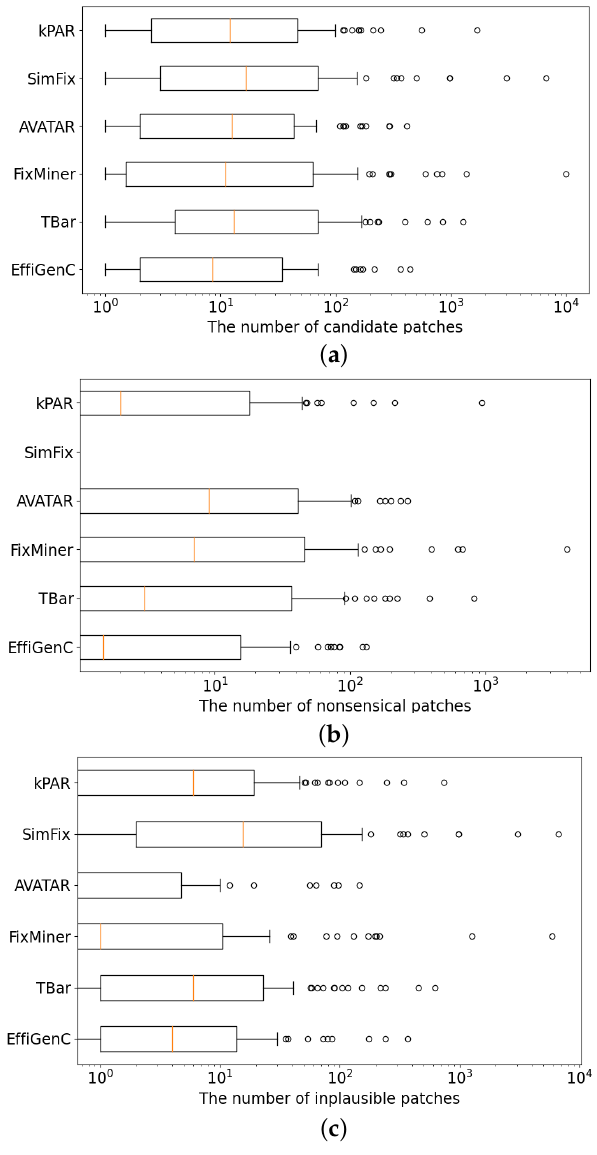
Figure 6. Result of NPC score. ( a ) Distribution of number of candidate patches; ( b ) distribution of number of nonsensical patches; ( c ) distribution of number of in-plausible